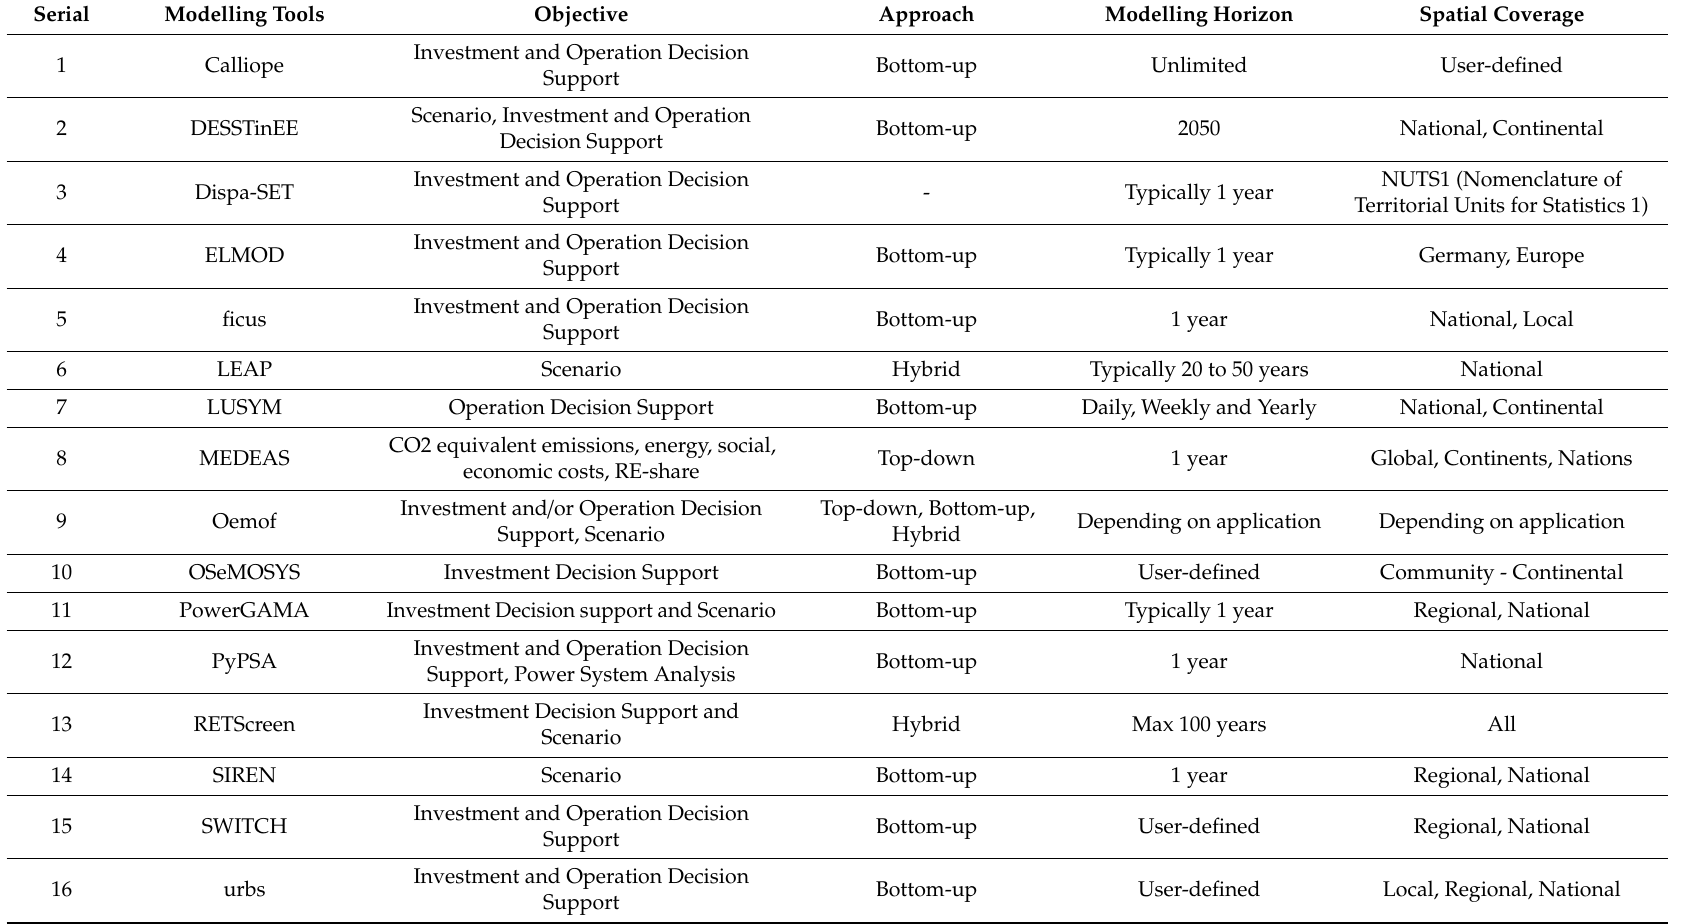
Table A2. Comparison between the 16 selected modelling tools (Part 1). Adapted from [98] and